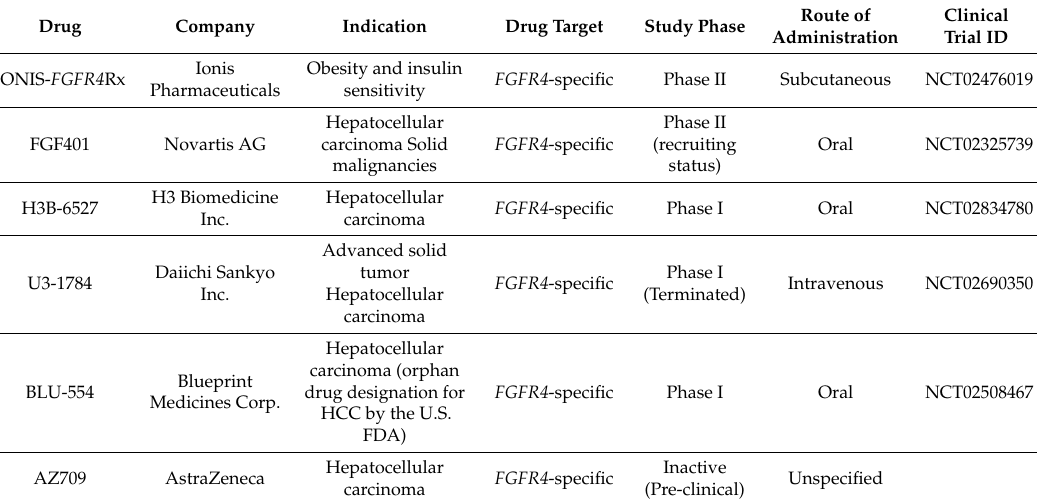
Table 2. FGFR4 -specific inhibitors under di ff erent phases of clinical